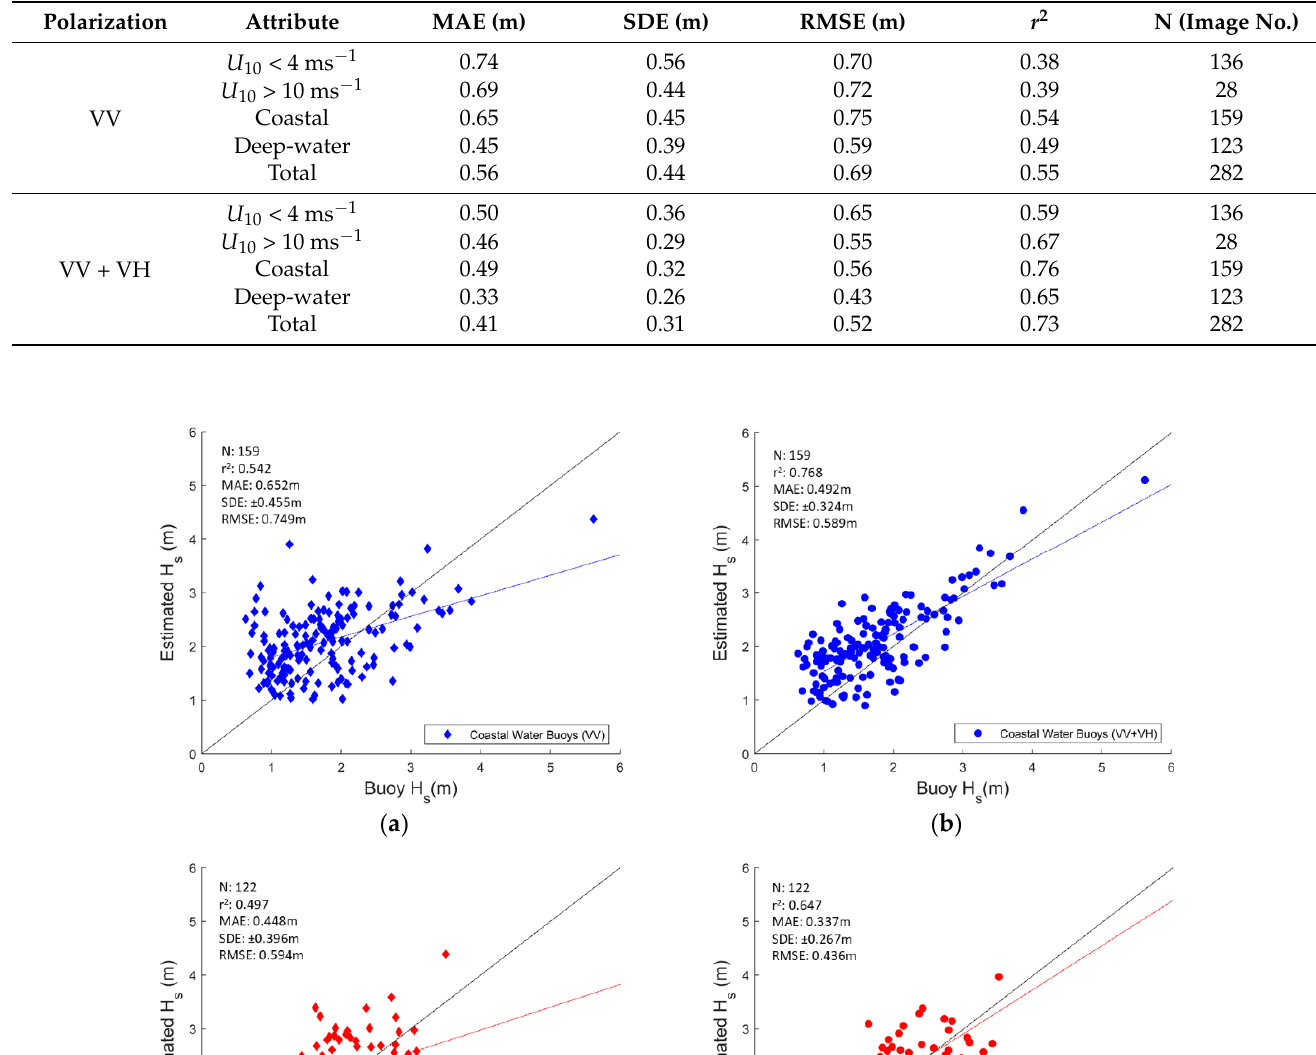
Table 3. Comparison of results between SAR images and National Data Buoy Center (NDBC) buoy data.